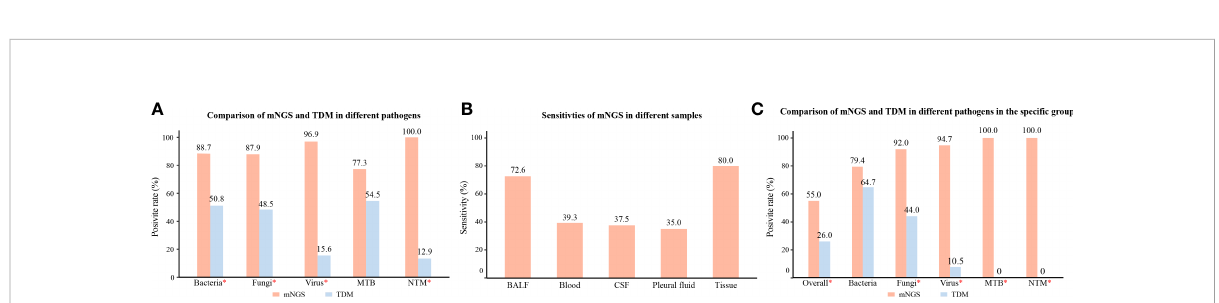
FIGURE 4 Subgroup analysis of different pathogens, samples, and speci fi c group. (A) Comparison of positive rates of mNGS and TDM for different pathogens in patients with identi fi ed pathogens. (B) Sensitivity rates of mNGS in different specimens. (C) Comparison of positive rates of mNGS and TDM for different pathogens in pathogen-identi fi ed patients with hematological tumors or rheumatic diseases; *, P value was < 0.05. mNGS, metagenomic next-generation sequencing; TDM, traditional diagnostic method; ID, infectious disease; MTB, Mycobacterium tuberculosis ; NTM, Nontuberculous mycobacteria ; BALF, bronchial alveolar lavage fl uid; CSF, cerebrospinal fl